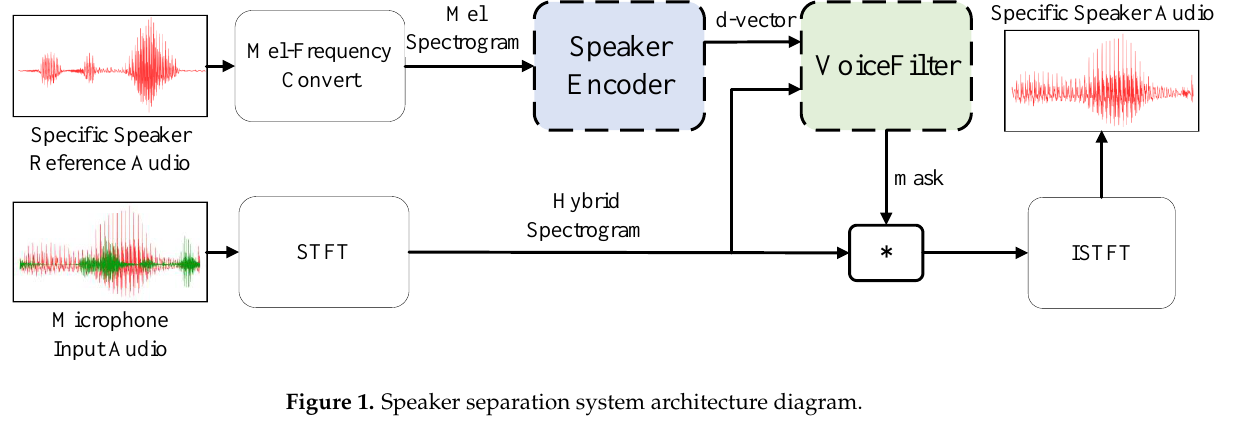
Figure 1. Speaker separation system architecture diagram.